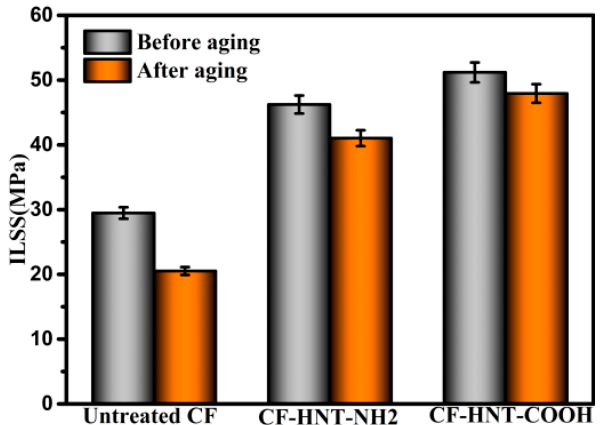
Figure 7. ILSS of composites before and after hydrothermal aging treatment.